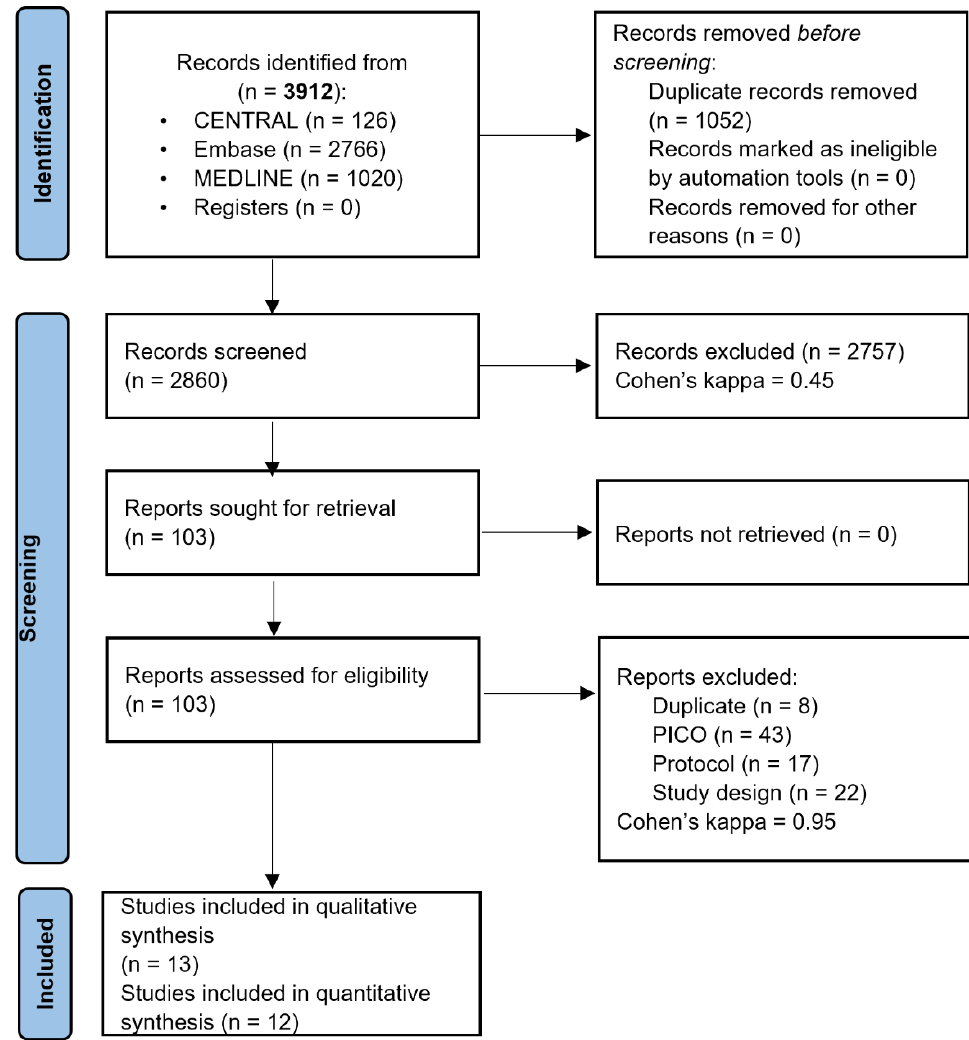
Figure 1. PRISMA 2020 flow diagram.